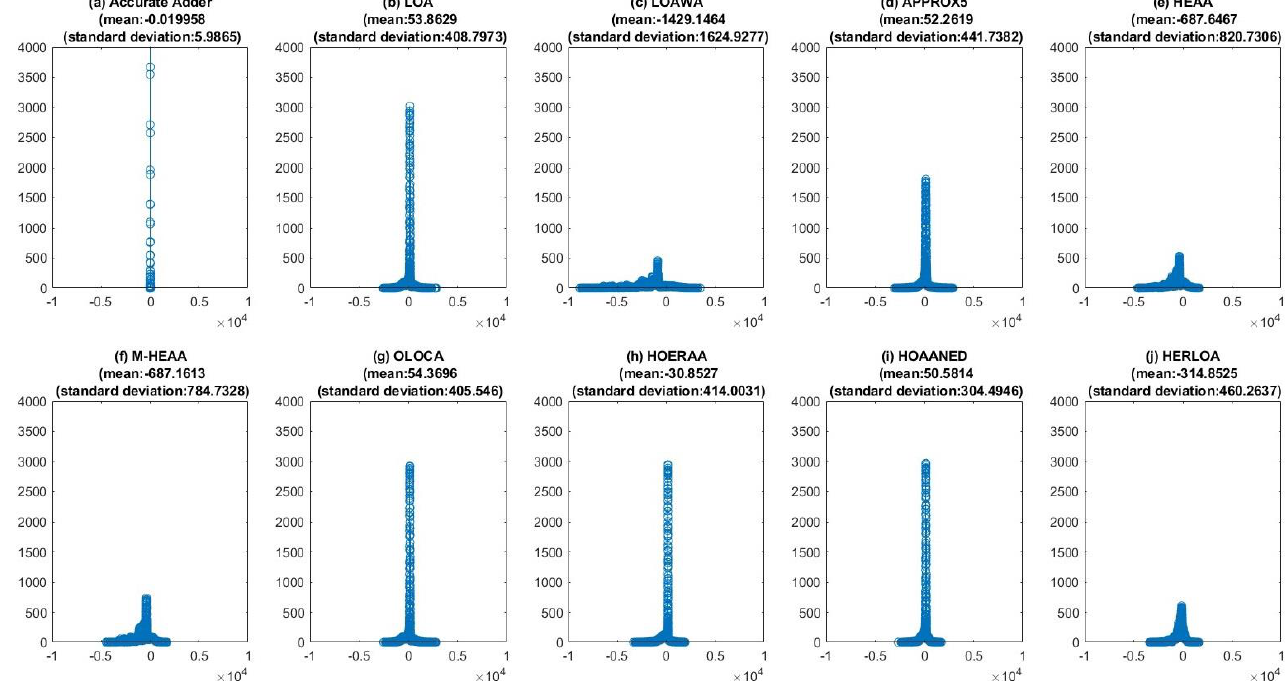
Figure 13. Plots showing the DPV between the Black Hole image compressed using accurate and approximate adders and the original Black Hole image, with the approximate adders having an 11-bit inexact part.